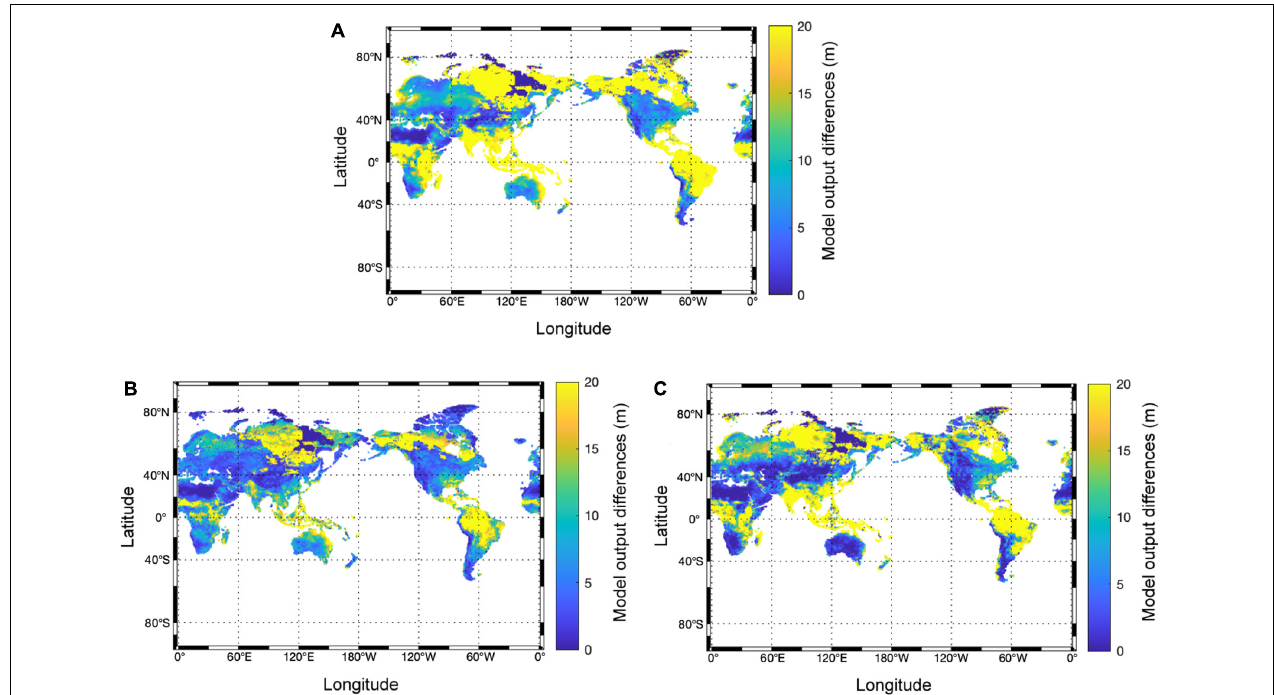
FIGURE 5 | Model output differences (m) between highest value and lowest value in each grid cell for precipitation (A) , evaporation (B) , and runoff (C) fluxes based on the scenario RCP8.5. For a given flux, model outputs represent the mean changes in each grid-cell over the period 1986–2005 to 2081–2099.